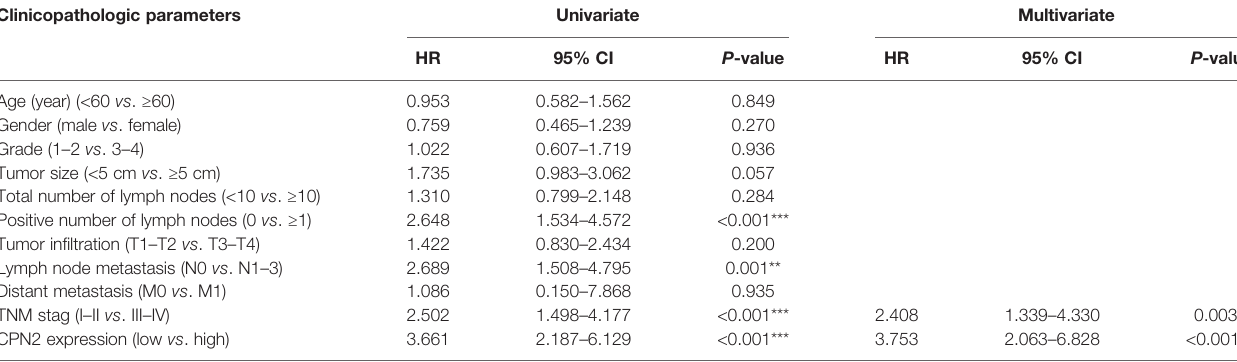
TABLE 2 | Univariate and multivariate Cox regression analyses of potential prognostic factors for lung cancer patients. Clinicopathologic parameters Univariate Multivariate HR 95% CI Age (year) (<60 vs . ≥